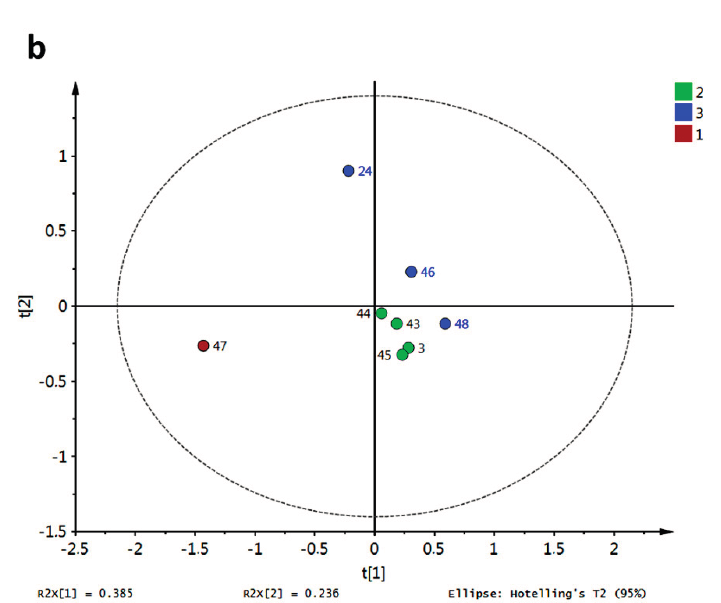
Figure 18. Discrimination of simple xanthones by antifungal activity against A. flavus based on docking scores. ( a ) PCA score plot grouped according to HCA; ( b ) PLS-DA score